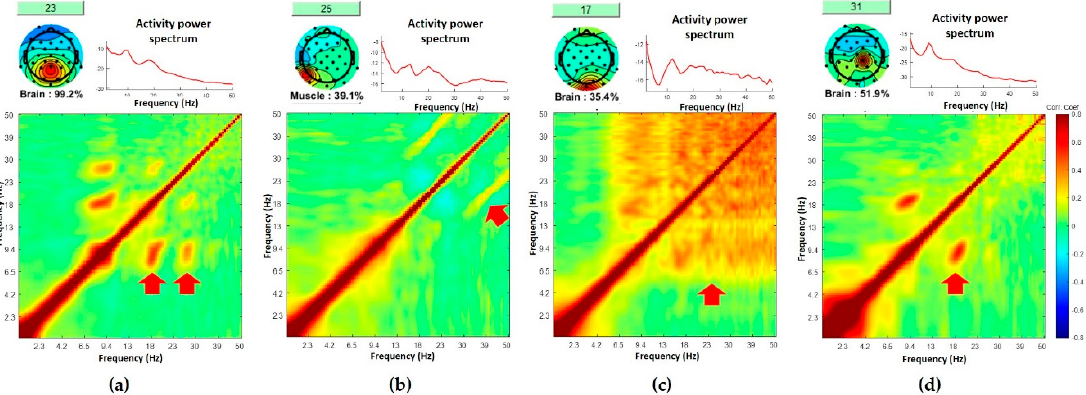
Figure 7. For each column, a class label suggested by ICLabel (top left, below scalp topography), power spectral density (top right), and comodulogram, i.e., cross-frequency PPC plot (bottom): ( a ) results from Subject 1 show the concordance between ICLabel and PPC results; ( b ) results from Subject 2 show the occurrence of a parallel line in beta–gamma coupling in possibly an EMG IC which is consistent with the label from ICLabel despite low label probability; ( c ) data from Subject 3 led to the discordance between “Brain” label suggested by ICLabel and comodulogram pattern unique to the muscle class indicated by the current study; ( d ) the presence of the alpha harmonics in comodulogram from Subject 4 can boost the label probability of ICLabel-suggested class label as “Brain” despite the current low likelihood.